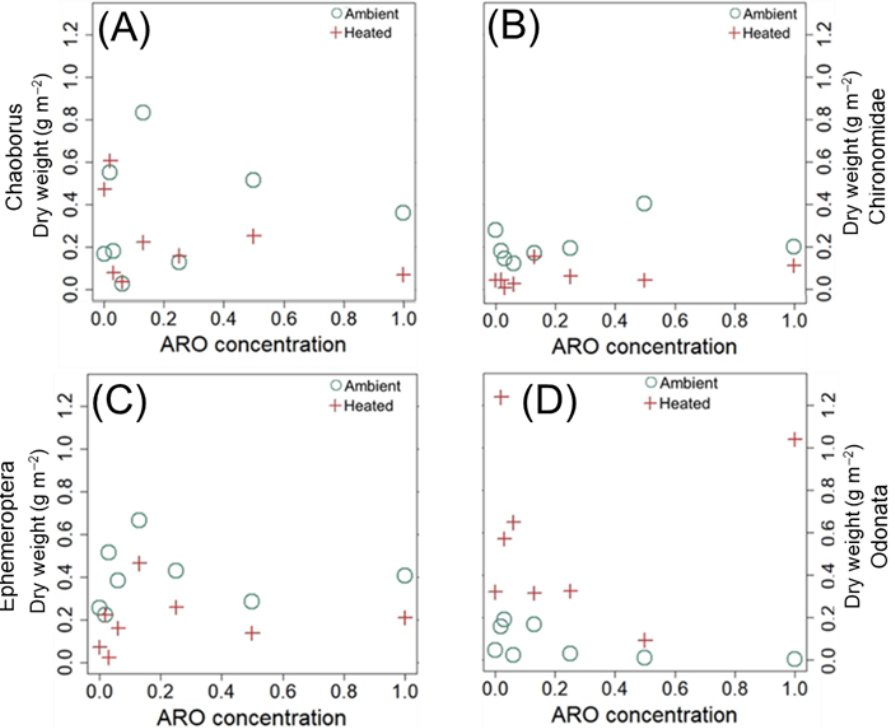
Figure 6. Mesocosms. Biomass of the four main groups of invasive invertebrates at the final sampling: ( A ) Chaoborus , ( B ) Chironomidae, ( C ) Ephemeroptera and ( D ) Odonata.